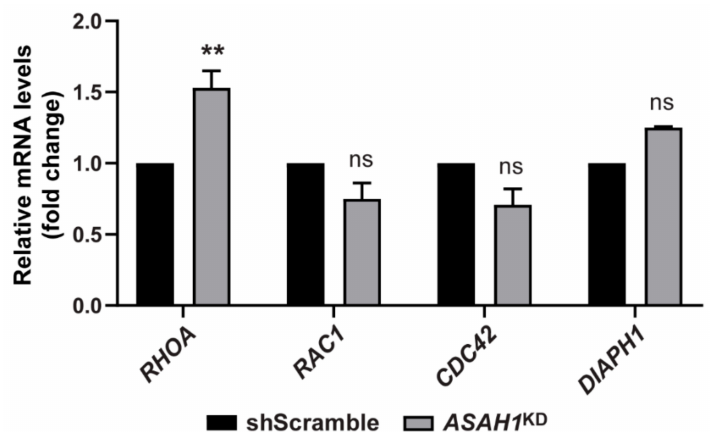
Figure 8. mRNA expression of the Rho GTPase family members. The graph represents the mRNA levels of RHOA , RAC1 , CDC42 , and DIAPH1 genes in ASAH1 KD cells relative to shScramble cells after normalization with the endogenous GAPDH gene. Values represent the mean ± SEM of two independent triplicate experiments. An ** indicates significance ( p = 0.0026, two-way ANOVA